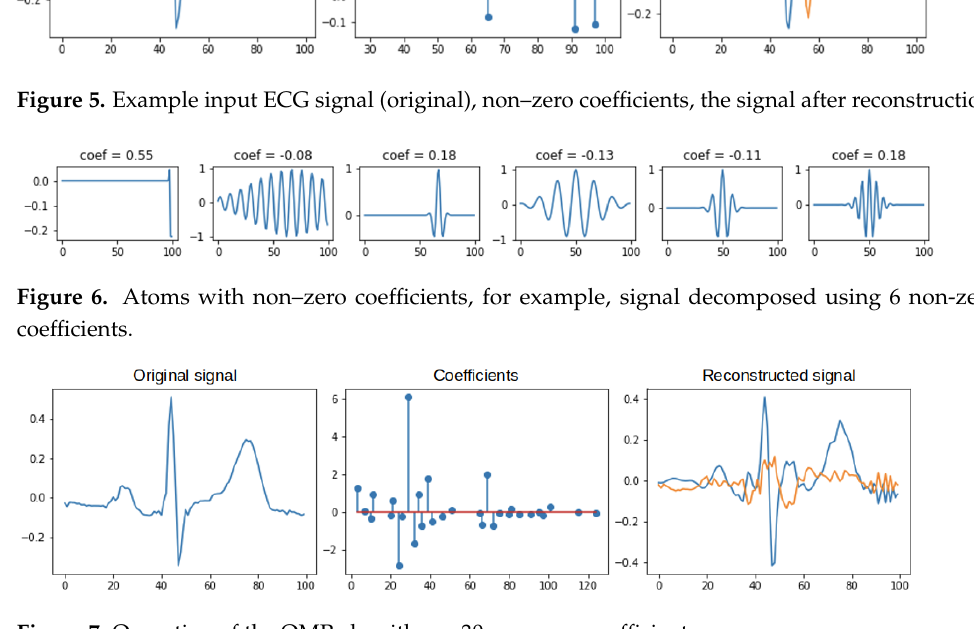
Figure 7. Operation of the OMP algorithm − 30 non–zero